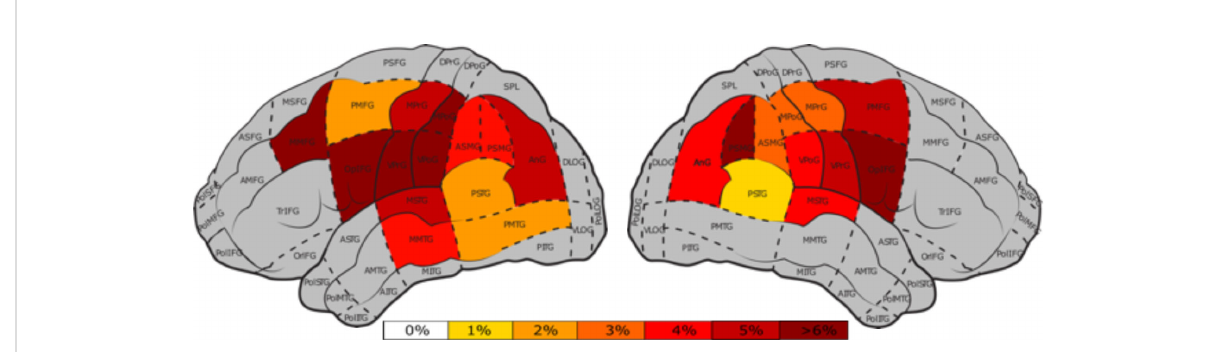
FIGURE 8 Percentage of nTMS errors per cortical area (47) for the tractogram-based protocol, for the left and right hemisphere. Gray areas represent areas with less than 25 nTMS stimulations and white areas indicate areas that were stimulated without occurance of any errors. The color bar indicates the nTMS errors ranging from 0%, white, to >6%, dark red.